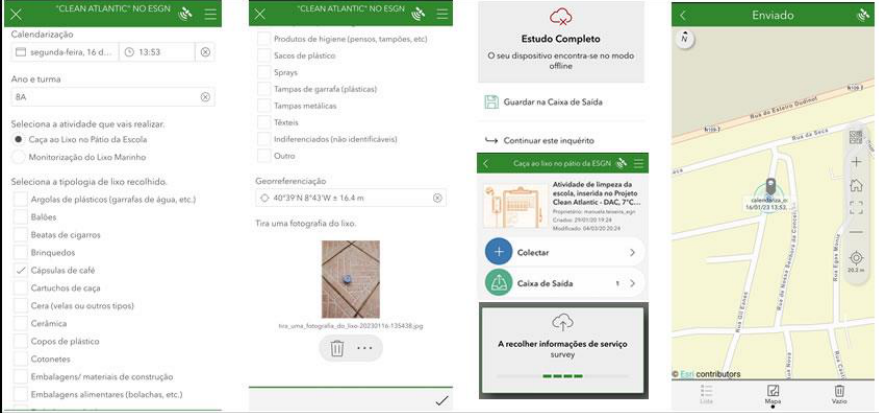
Figure 16. Collecting data with Survey123.